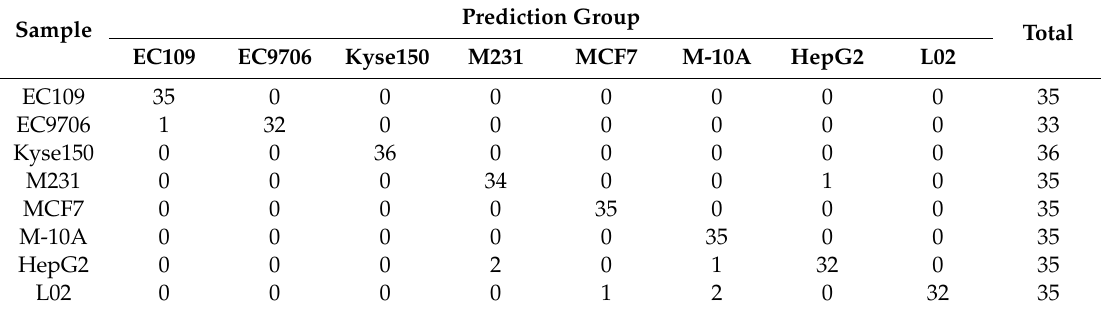
Table 2. PCA-LDA classification of eight di ff erent cell-derived exosomes by the 600–760 cm − 1 region. Sample